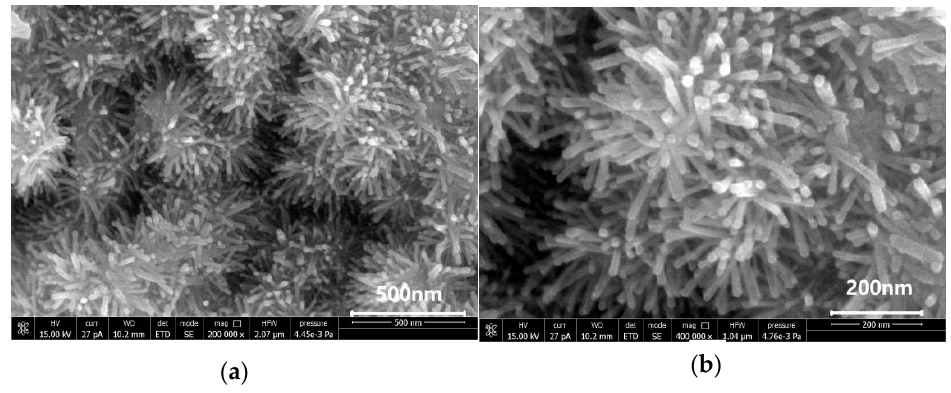
Figure 7. FSEM images of SnO 2 (NW): ( a ) 500 nm, ( b ) 200 nm.